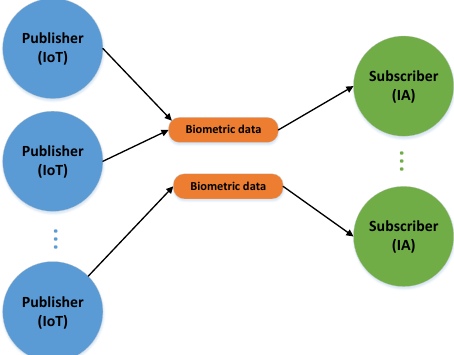
Figure 8. Structure of topics for publisher-subscriber mechanism (a fragment).